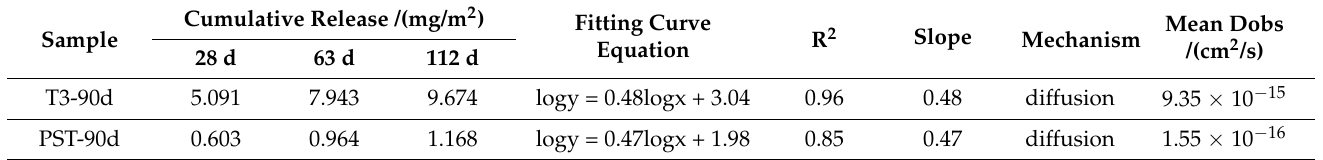
Table 3. Cumulative As release, mean Dobs, and log-transformed fitting curve equation. Sample